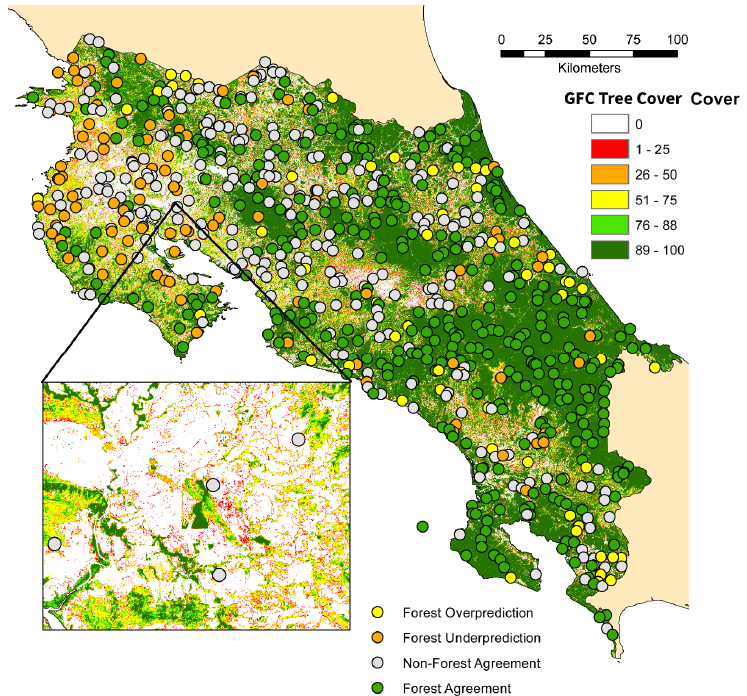
Figure 9. GFC tree cover map (2015), showing the spatial distribution of forest cover errors when compared to reference data (n = 1154). The point colors indicate the type of confusion matrix errors. Remote Sens. 2020 , 12 , 3226